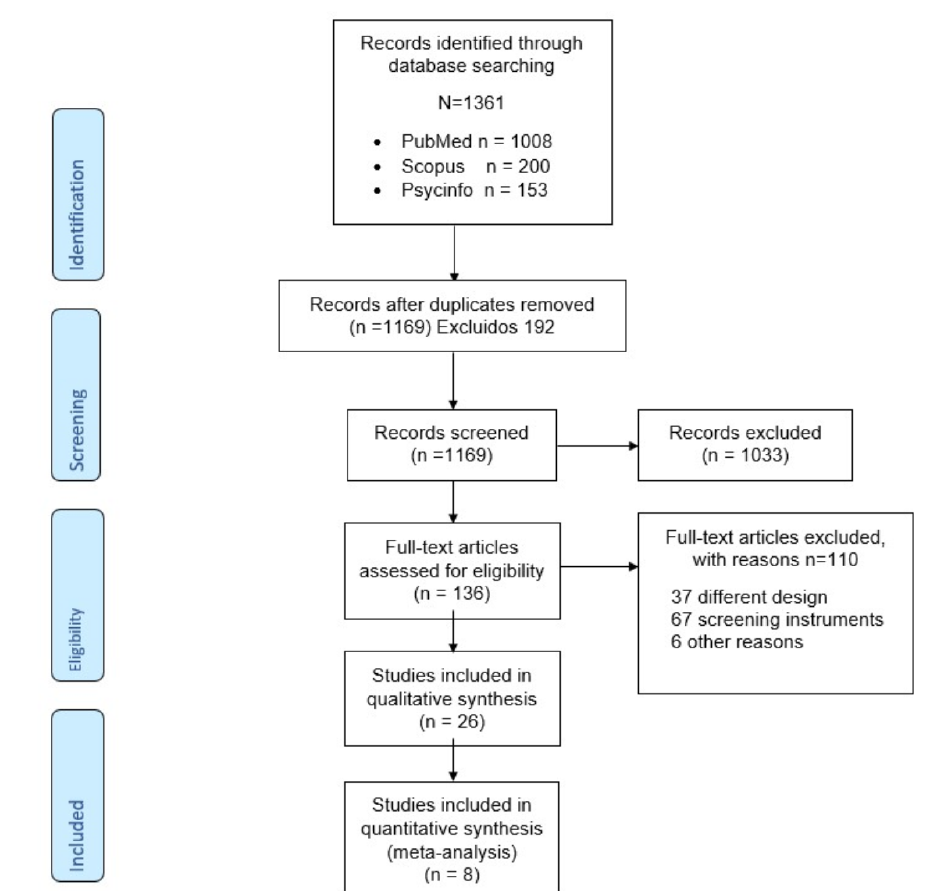
Figure 1. Study selection flow